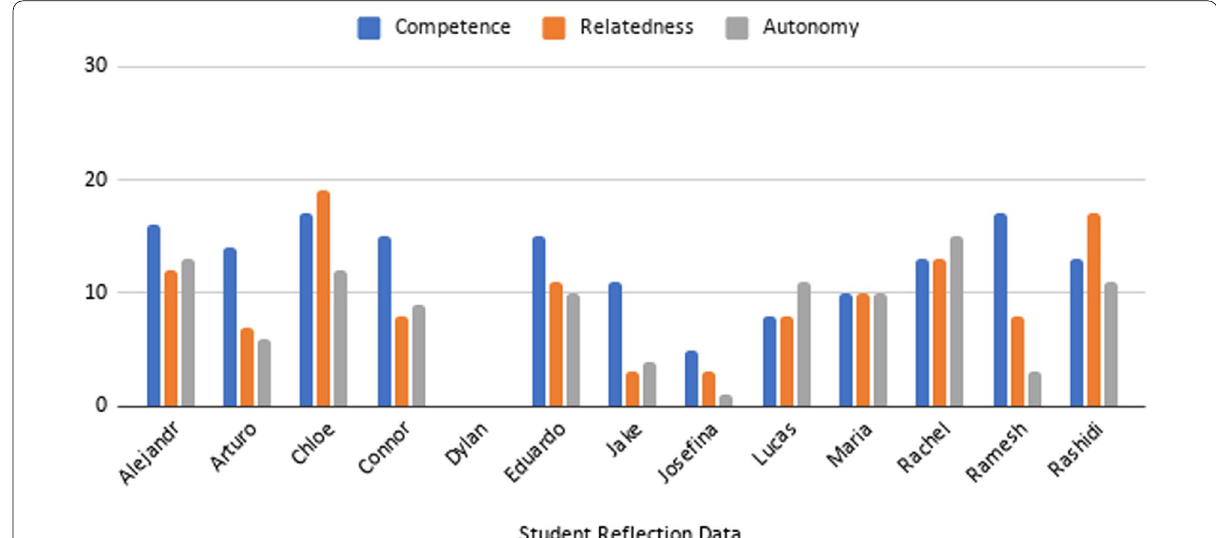
Fig. 2 Frequency counts of SDT constructs after the transition to remote